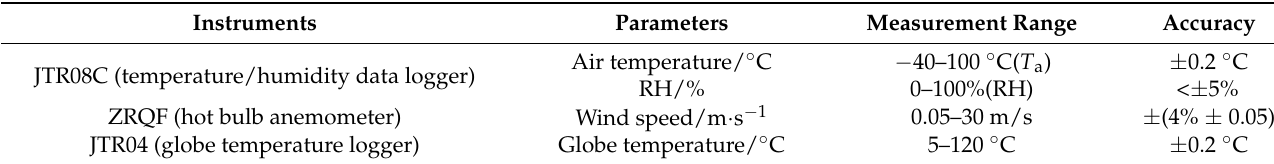
Table 2. Instruments of the field survey and their specific